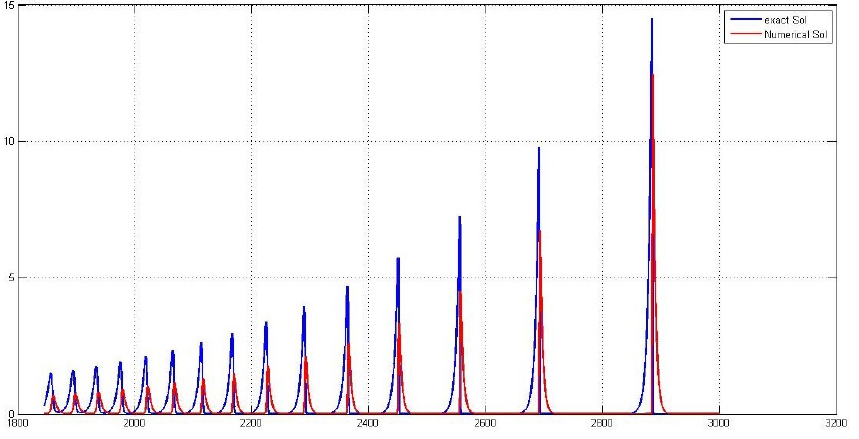
Figure 1. The graphical presentation of the approximate solution x of (9) and the exact